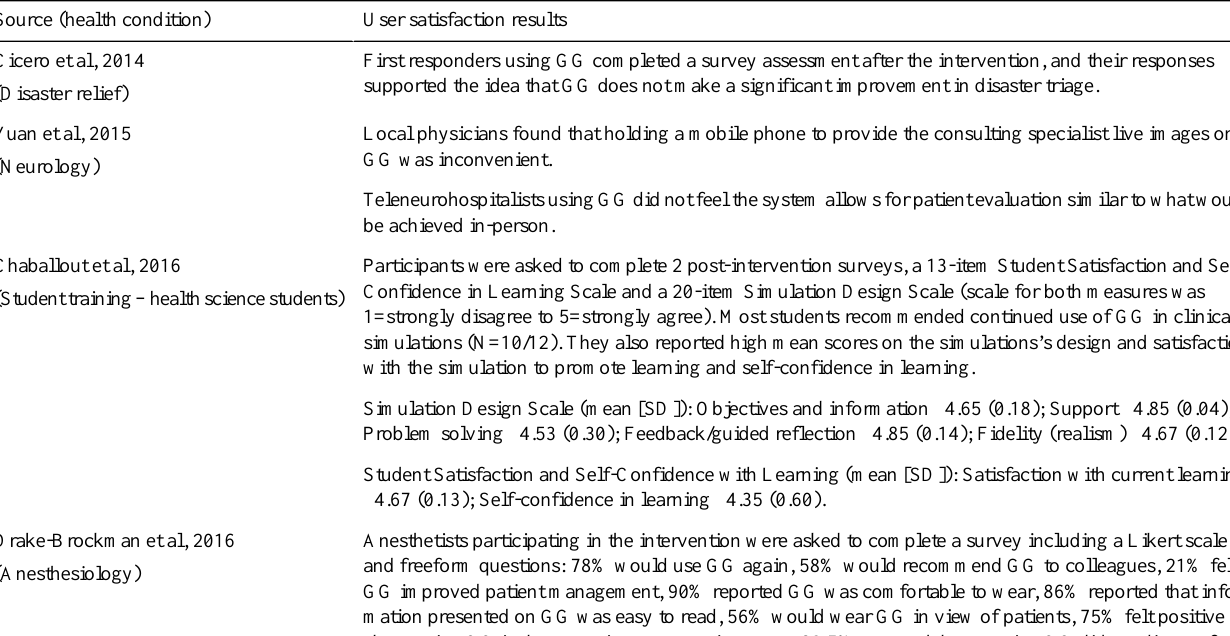
User satisfaction resultsSource (health